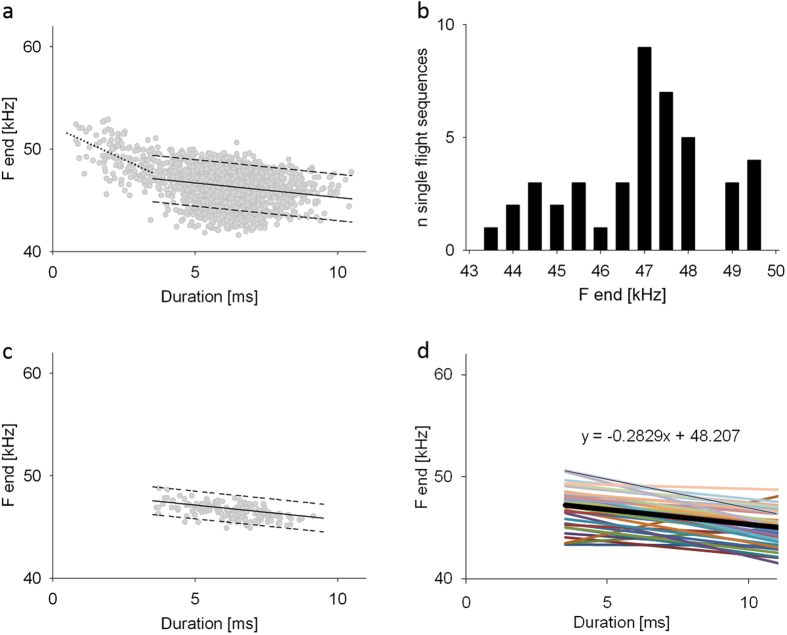
(a) Search (≥3.5 ms) and approach calls (<3.5 ms) from 43 sound sequences (2147 calls) of single flying P. pipistrellus with linear regressions (solid and dotted line, respectively). The dashed lines indicate the twofold standard deviation and limit the species-specific transmission channel for search signals. (b) Distribution of individual terminal frequencies (measured as average frequencies of calls with durations of 5–6 ms) of single flying individuals of P. pipistrellus. (c) Individual transmission channel of the terminal frequency of a single flying P.pipistrellus in search flight. (d) Linear regressions for the search calls of the analyzed 43 single flight sequences. Thicker black line indicates mean of all individual regressions.